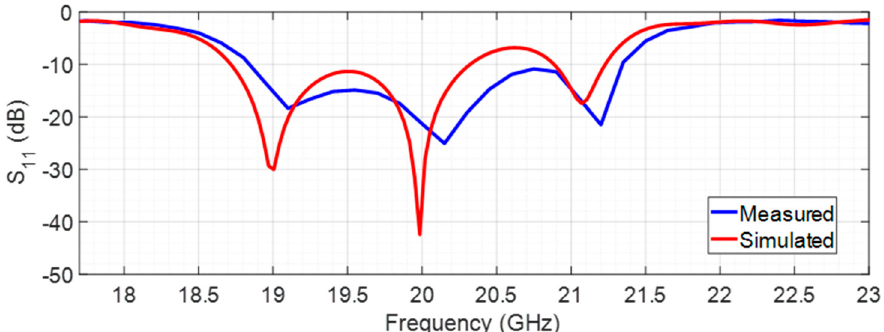
Figure 15. Simulated and measured reflection coefficient of the filtenna to 20 GHz.